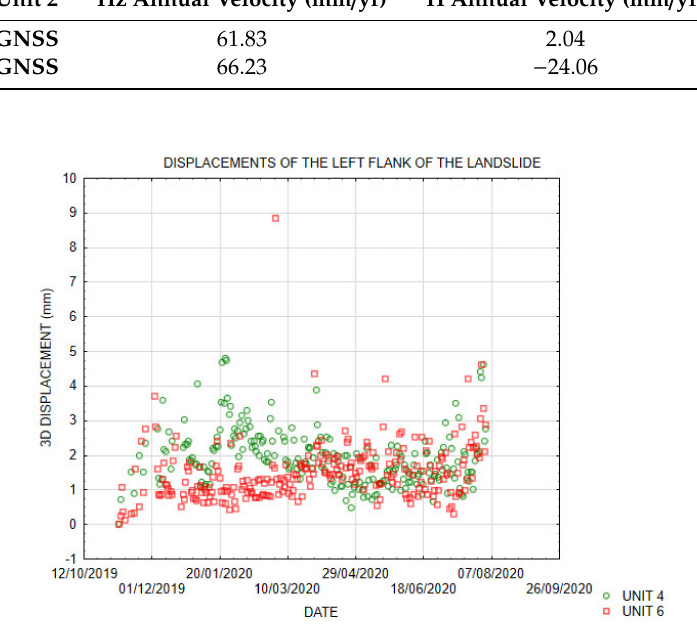
Figure 14. Time series of the displacements observed at the left flank of the